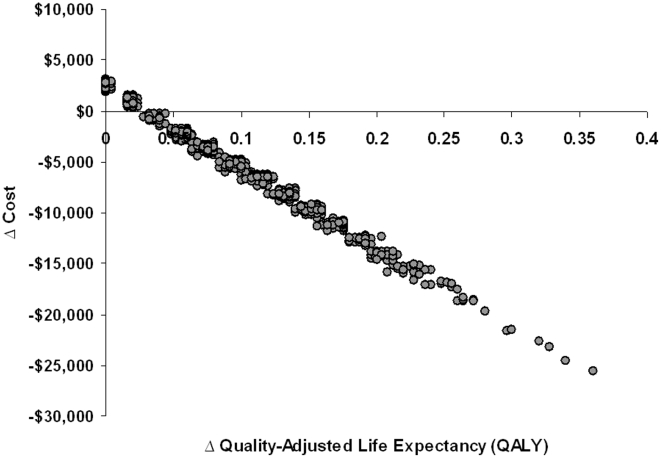
Projected Cost-Effectiveness of Directly Observed Highly-Active Antiretroviral Therapy in Pregnancy.The estimated cost-effectiveness of directly observed highly-active antiretroviral therapy (HAART) as compared to self-administered HAART. Each grey circle represents one of 5000 simulated trials comparing the two strategies, with 200 women in each trial. The incremental cost of directly observed therapy is on the Y-axis, while the incremental change in quality-adjusted life expectancy among infants is on the X-axis. Under base-case assumptions, directly observed therapy reduced costs and increased quality-adjusted life expectancy in most trials.